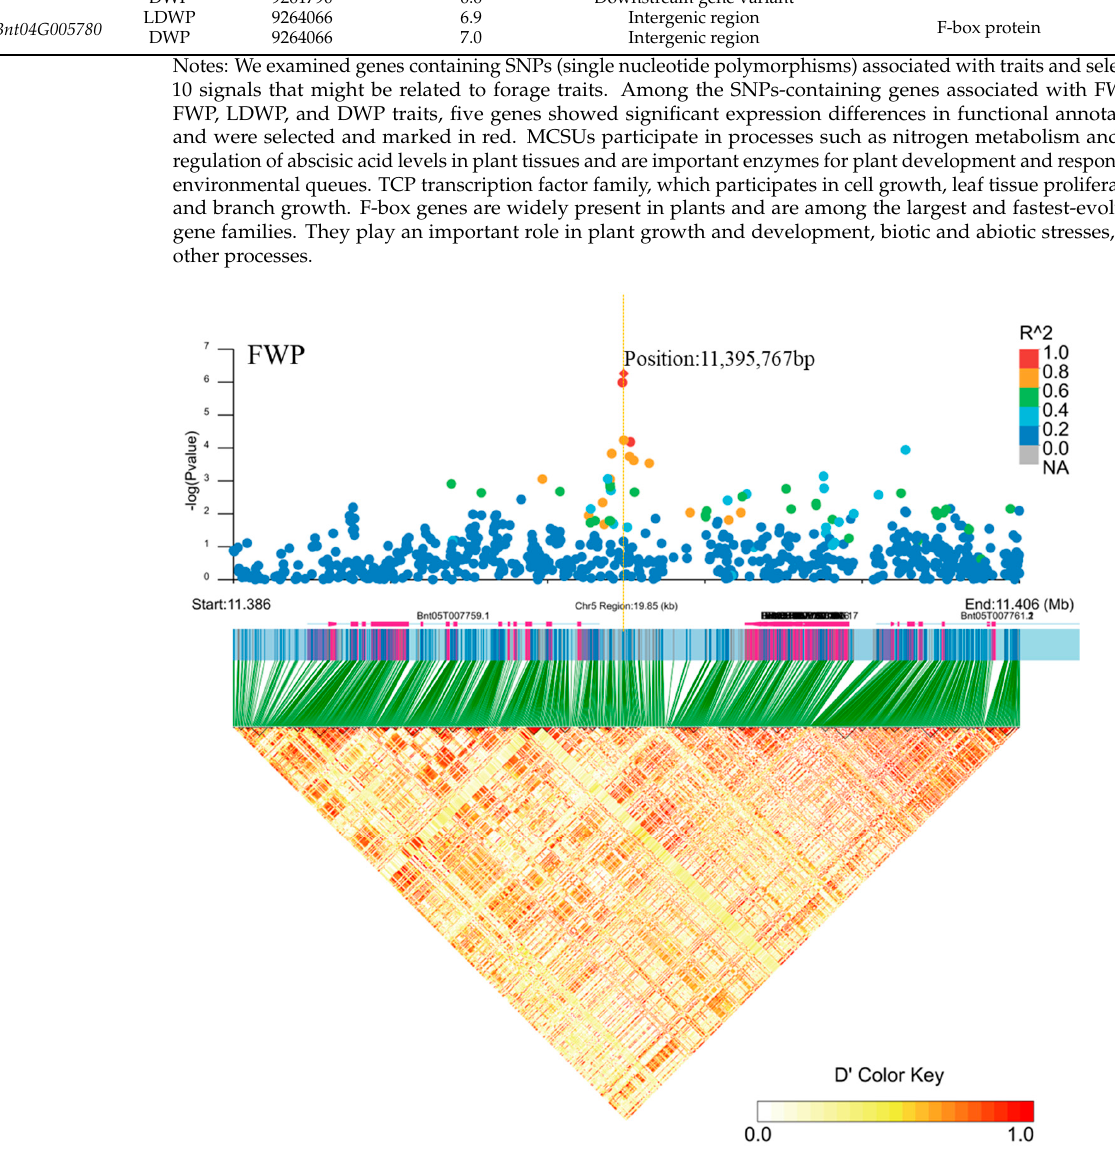
Figure 9. Candidate genes for FWP (fresh weight per plant) on chromosome 5. Manhattan plot (top) and linkage disequilibrium heatmap (bottom) of genomic region surrounding Bnt05G007759 . A significant signal was associated with FWP on chromosome 5, as assessed using EMMAX (Efficient Mixed-Model Association eXpedited), and it was in Bnt05G007759 . The graph shows genomic posi- tions ( x axis) and the respective significance expressed as − log 10 p value ( y axis). The genomic posi- tion spans ~20 kb on either side of the peak SNP (single nucleotide polymorphism), indicated by an orange dashed vertical line. The larger the R^2 (Coefficient of correlation) values (indicated in the legend on the top right), the stronger the degree of association. The red diamond indicates the asso- ciated SNP, and the lighter colors of the remaining markers reflect their successively lower R^2 val- ues. D’ represents the correlation between different loci, the larger the value, the stronger the corre- lation and the higher the degree of linkage disequilibrium. The heat map showed that there was a strong linkage between the regions 11.386–11.406 Mb.